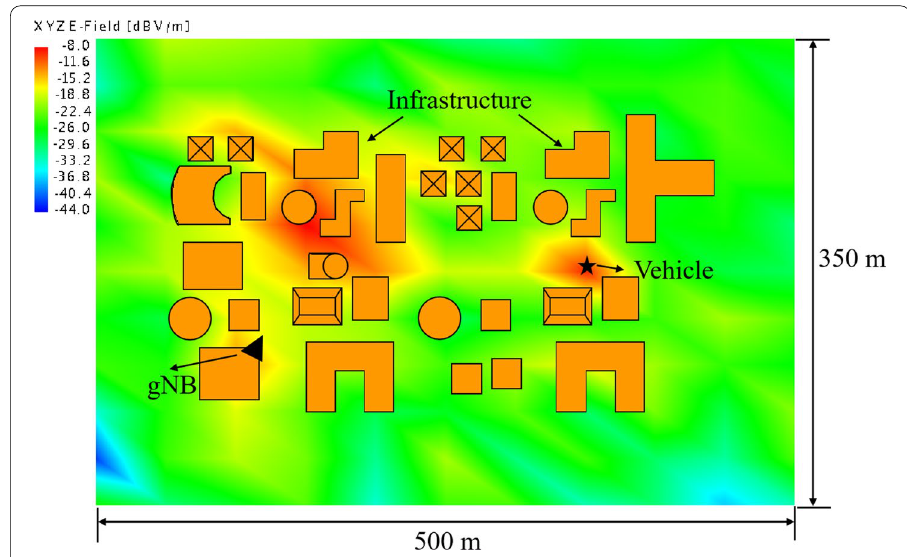
Fig. 22 Supplementary effect drawing of blind area of mobile station for vehicle communication. The blind area is perfectly eliminated by the proposed automobile